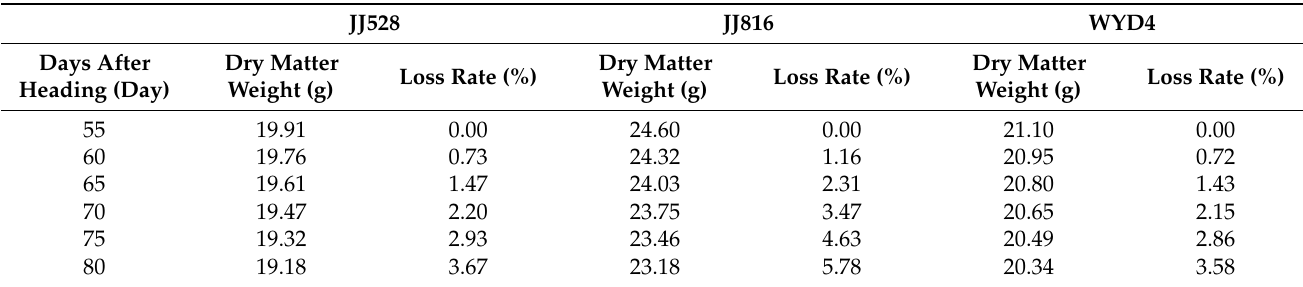
Table 3. Dry matter weights (based on a standard 15% moisture content) and loss rates of three varieties on different days after heading. JJ528